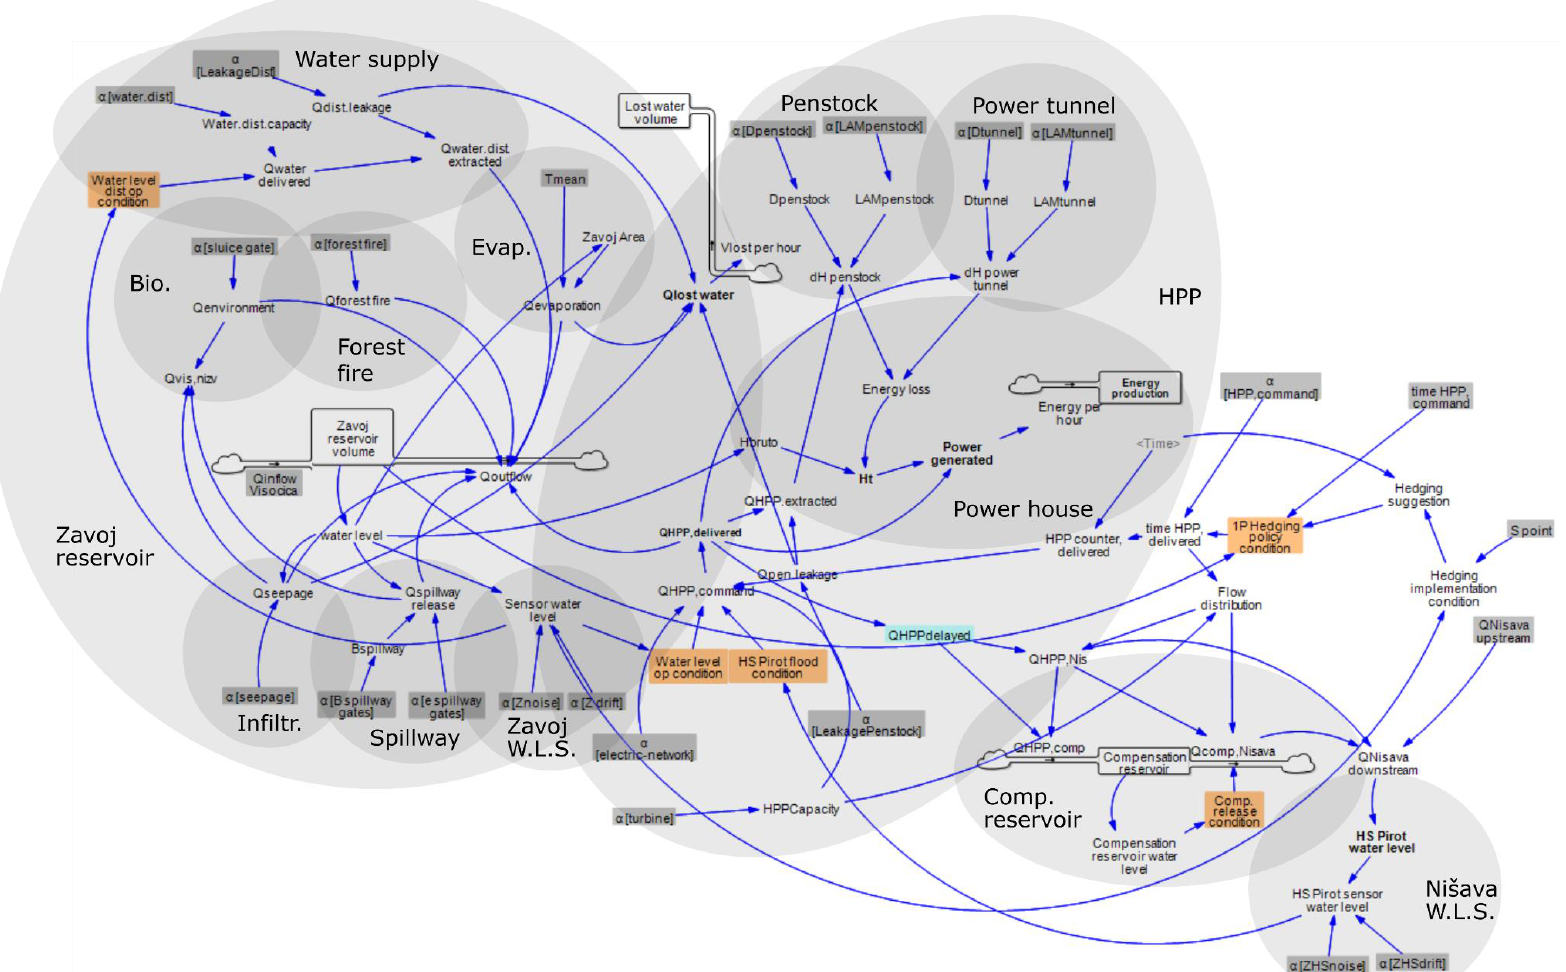
Figure 6. Pirot DRS dynamic model representation using Vensim software with reference to the subsystems defined in Figure 5, for MMORS model variant.